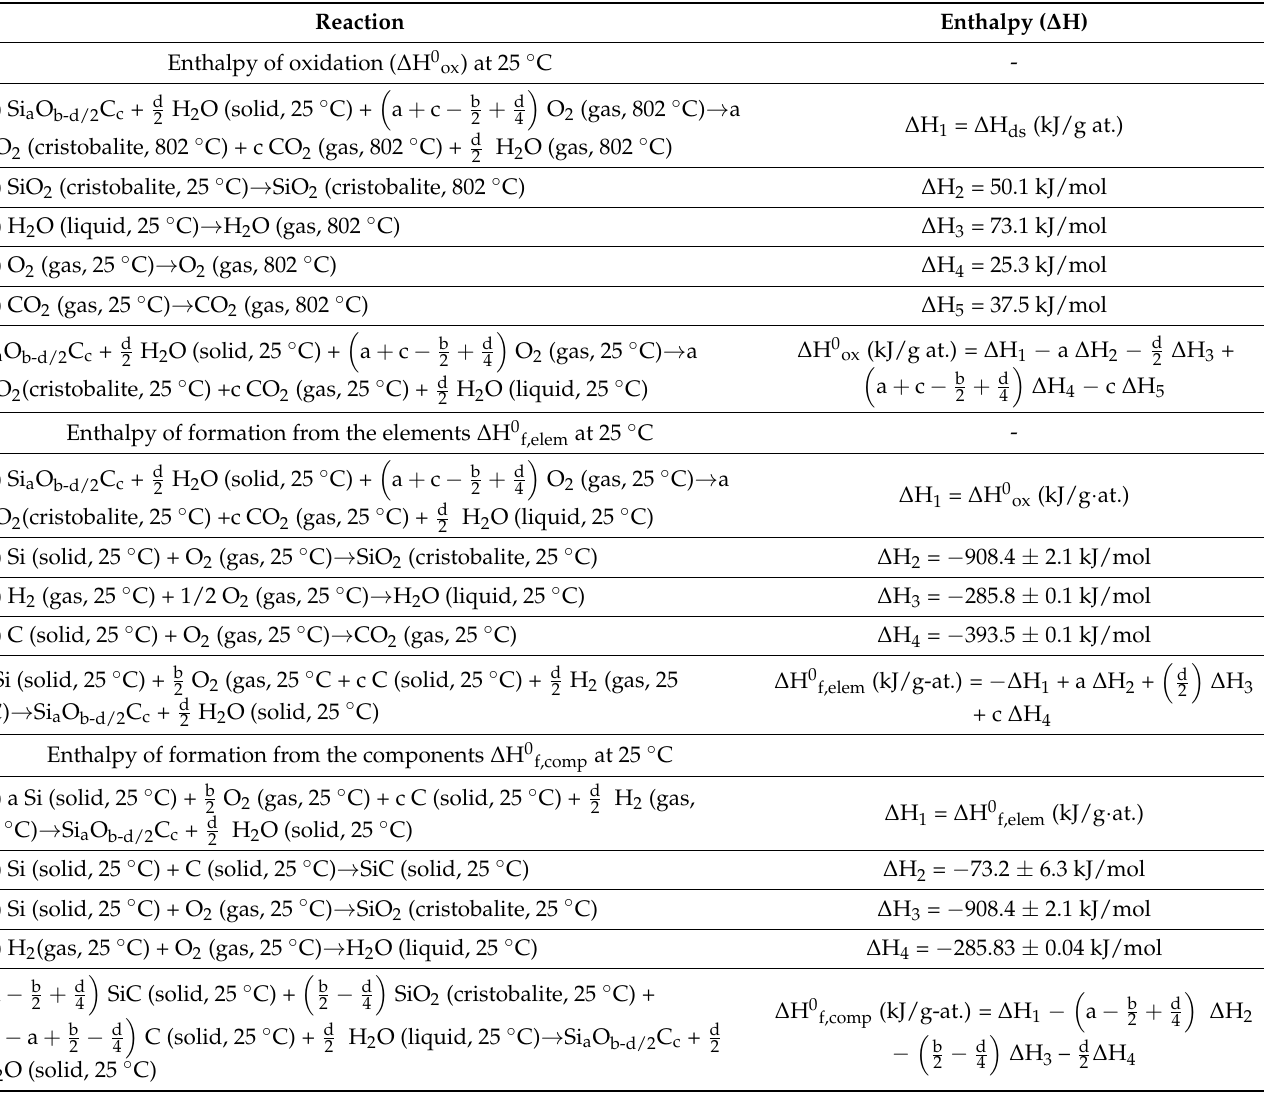
Table 5. Thermodynamic cycles for SiOC(H) heat of formation.